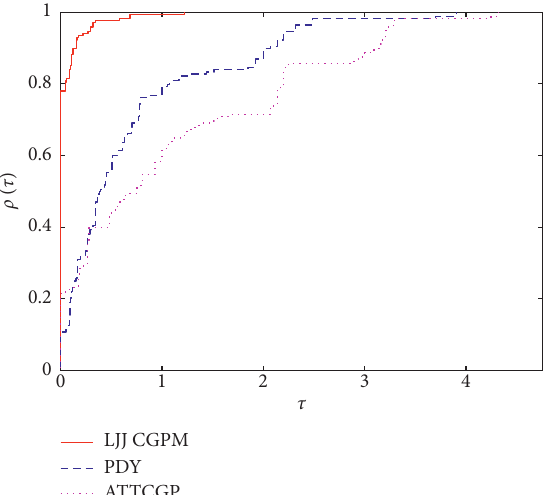
Figure 3: Performance profiles on Itr.